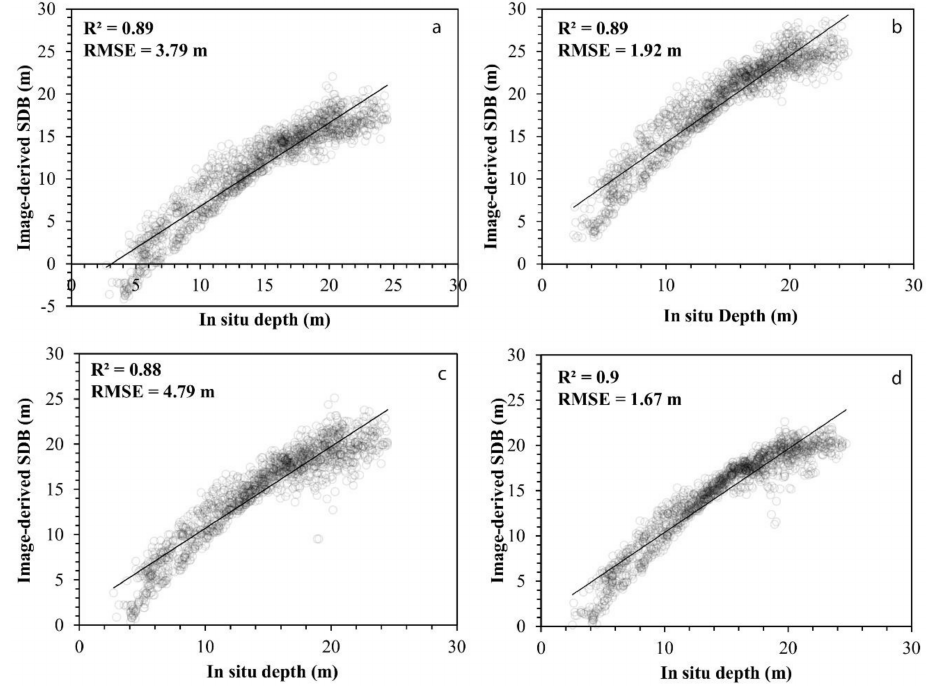
Figure 5. Validation plots of in situ depth points ( x -axis) against image-derived bathymetries ( y -axis) implementing the Lyzenga85 model which displays the best accuracy from the median Sentinel-2 composites of Apokoronas site for successive methodological steps including: ( a ) the initial median Sentinel-2 composite; ( b ) a normalised median Sentinel-2 composite using the shown pseudo-invariant (PIF) features in the zoomed maps of Figure 3b; ( c ) a 3 × 3 smoothed median Sentinel-2 composite; ( d ) a 3 × 3 smoothed and normalised median Sentinel-2 composite which shows the best accuracy among the four models of the present study in the Apokoronas site.